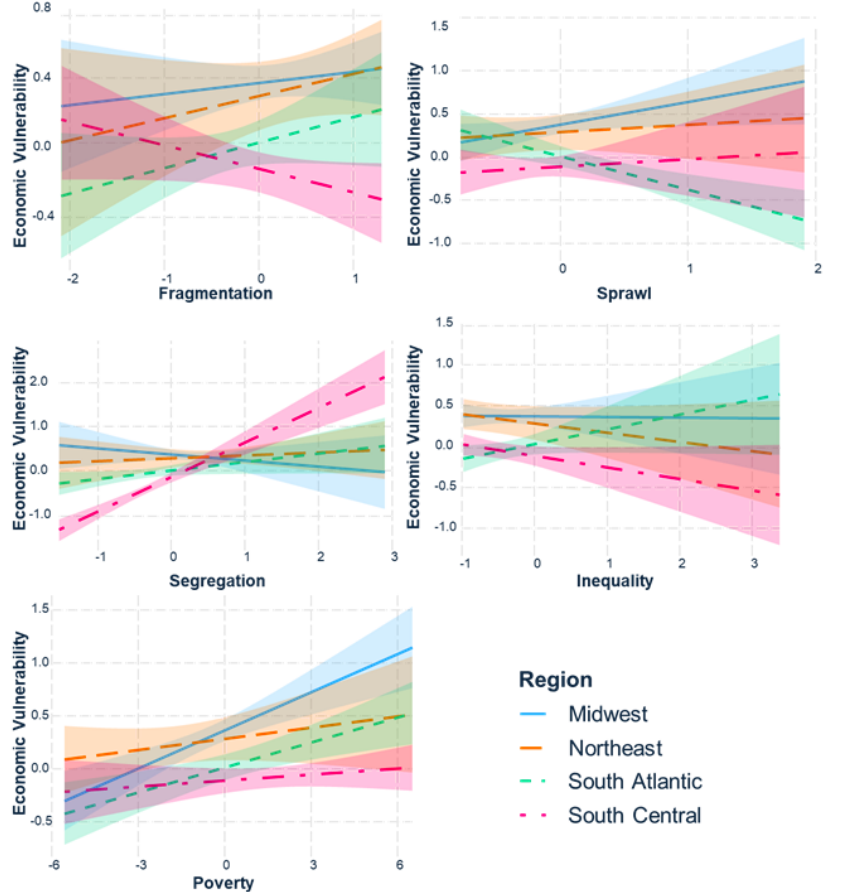
Figure 4. Subgroup plots by region for interaction model.